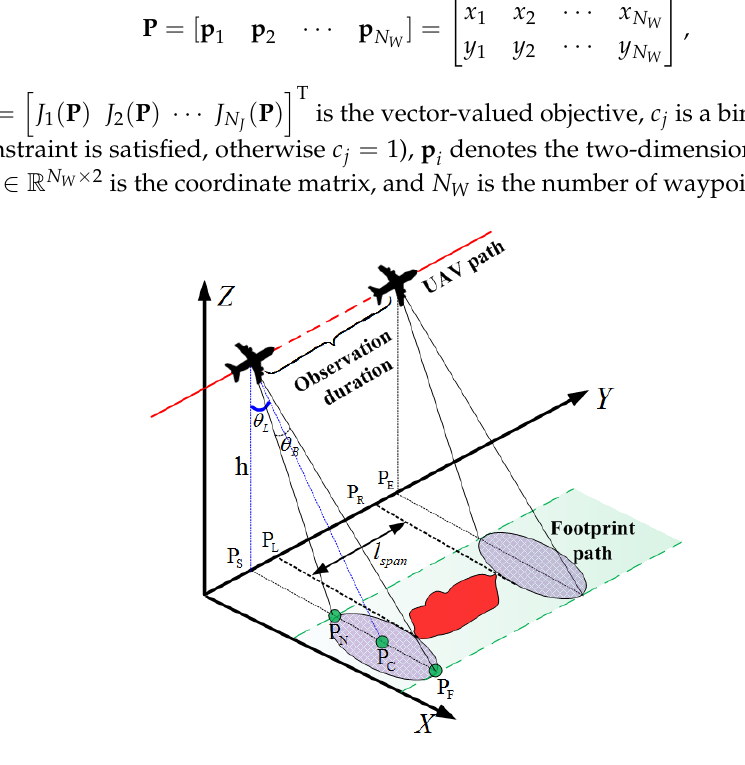
Figure 2. Observation geometry model of UAV SAR.